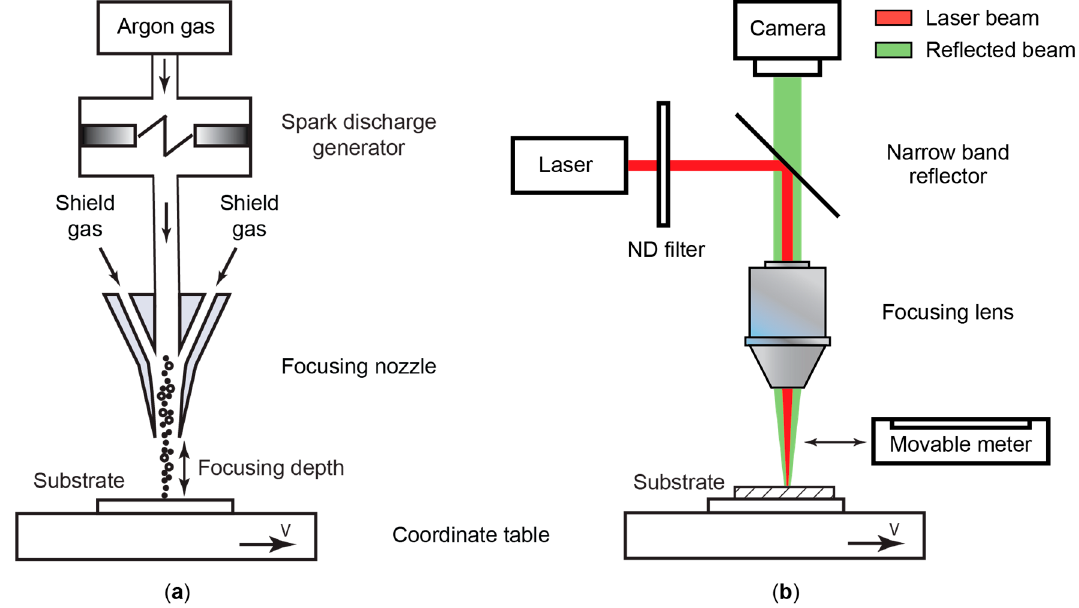
Figure 1. The sketches of ( a ) the setup for the formation of silver NP arrays and ( b ) the setup for local laser sintering of deposited silver NP arrays.